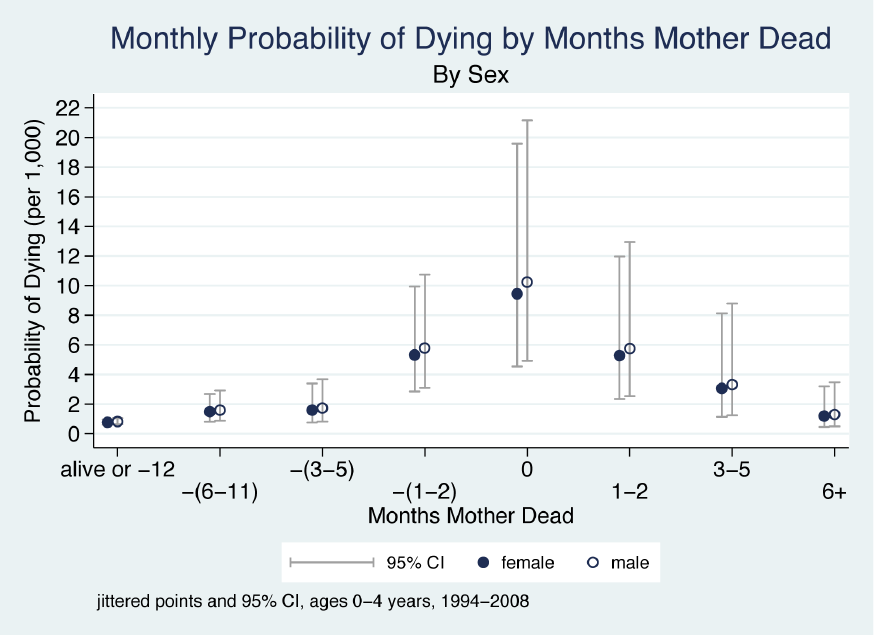
Figure 2. Monthly probability of child death in Agincourt sub-district, South Africa (1994–2008) by time before/after mother’s death and sex of child. On the x- axis, the mother’s death occurs in month 0, and time periods before and after her death are shown to the left and right of month 0, respectively. Children whose mother did not die during the study are included in the time period ‘‘alive or 2 12’’. Jittered (offset) points to reduce overplotting.